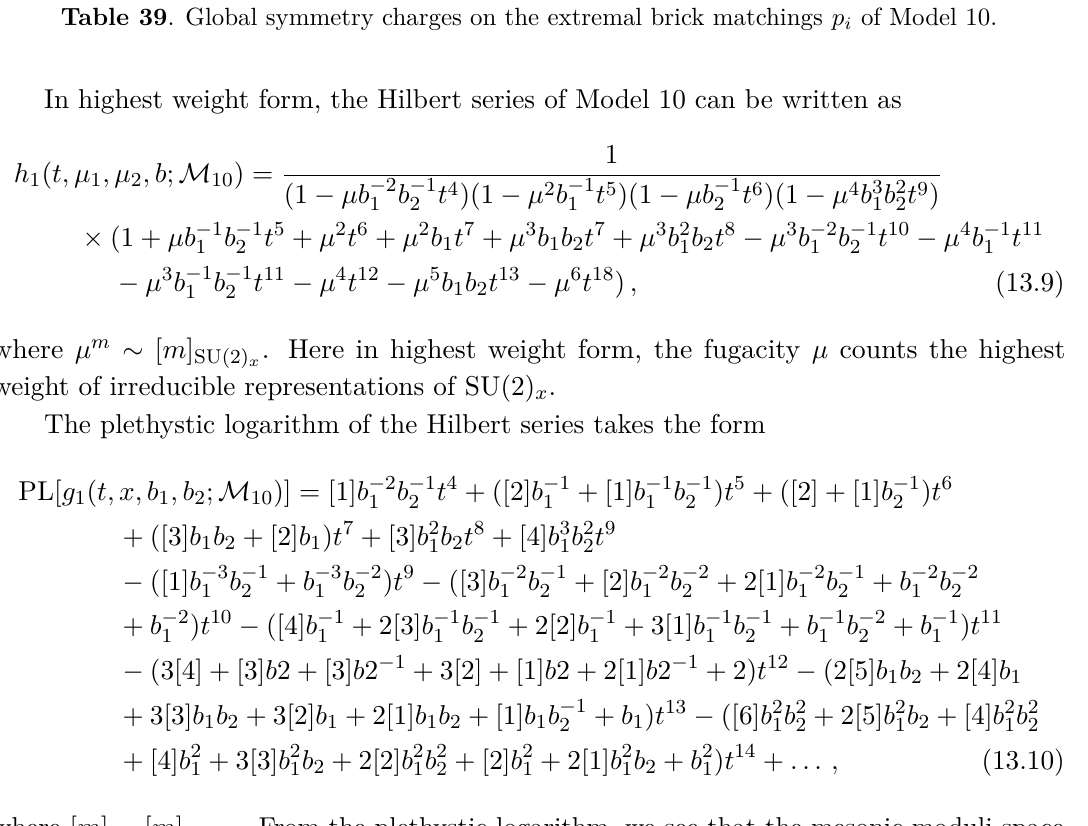
Table 39 . Global symmetry charges on the extremal brick matchings p i of Model